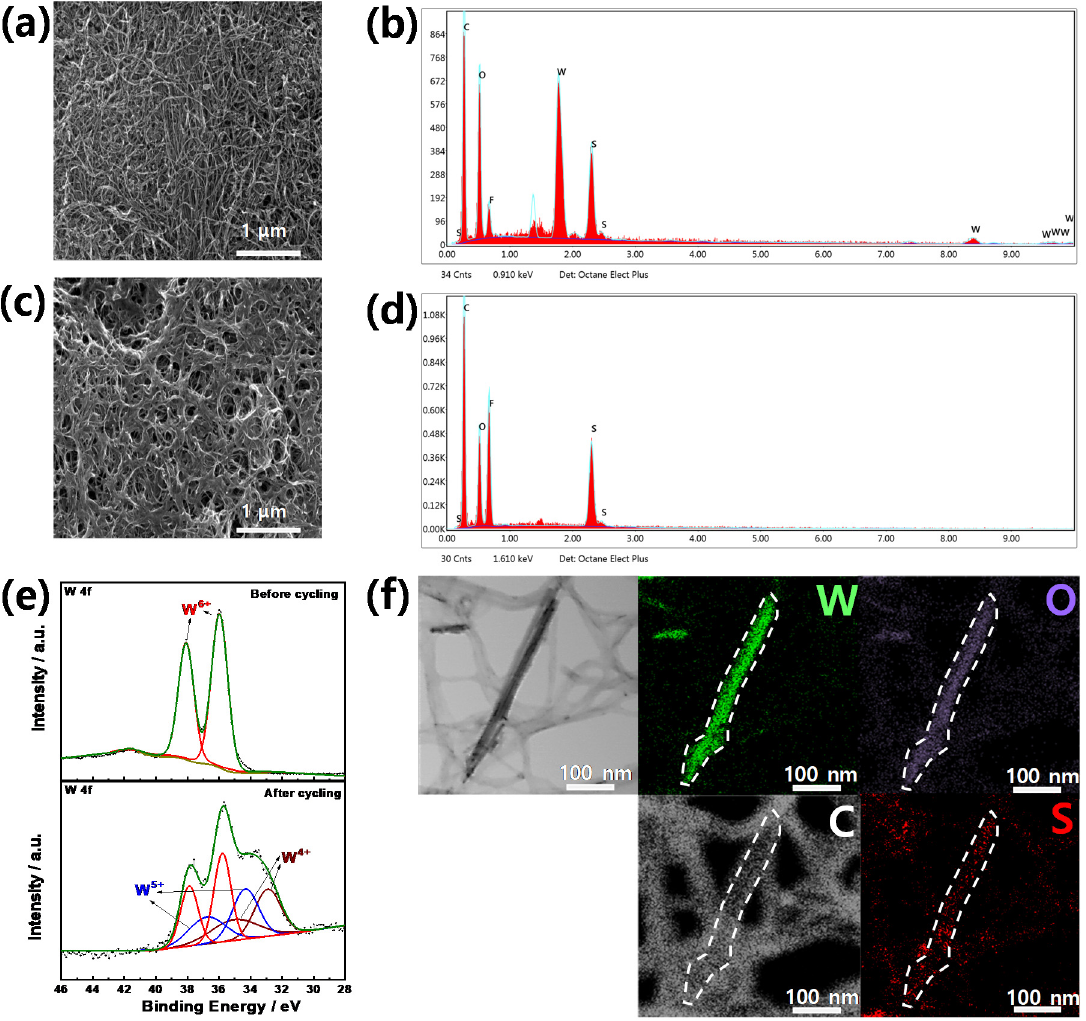
Figure 7. SEM images and area EDS measurements of WNW/CNT and CNT interlayers and their charged states after 100 cycles: ( a , b ) WNW/CNT interlayer and ( c , d ) CNT interlayer. ( e ) XPS spectra (W 4f) of the WNW/CNT interlayer before and after cycling. ( f ) TEM images of a cycled WNW/CNT interlayer with EDS mapping images of tungsten, oxygen, sulfur, and carbon.